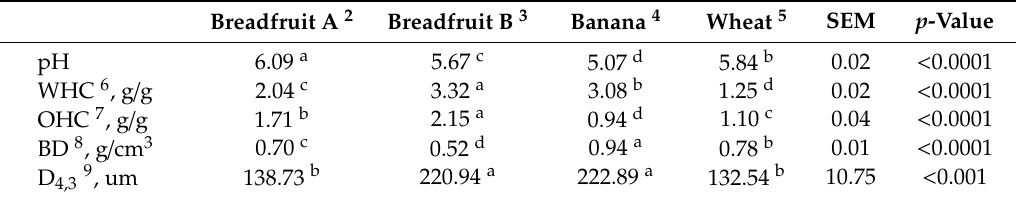
Table 2. The functional properties of tropical flours compared with a traditional flour 1